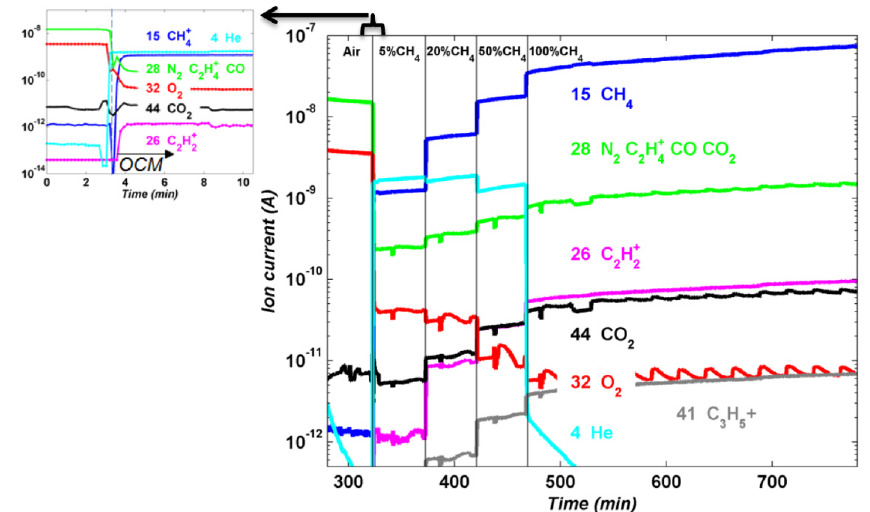
Figure 26. Mass spectroscopy data that correspond to the following masses: 4 (He—cyan), 15 (CH 4 —blue), 28 (N 2 , CO, C 2 H 4+ —green), 32 (O 2 —red), 44 (CO 2 —black) and 26 (C 2 +—pink) [28].